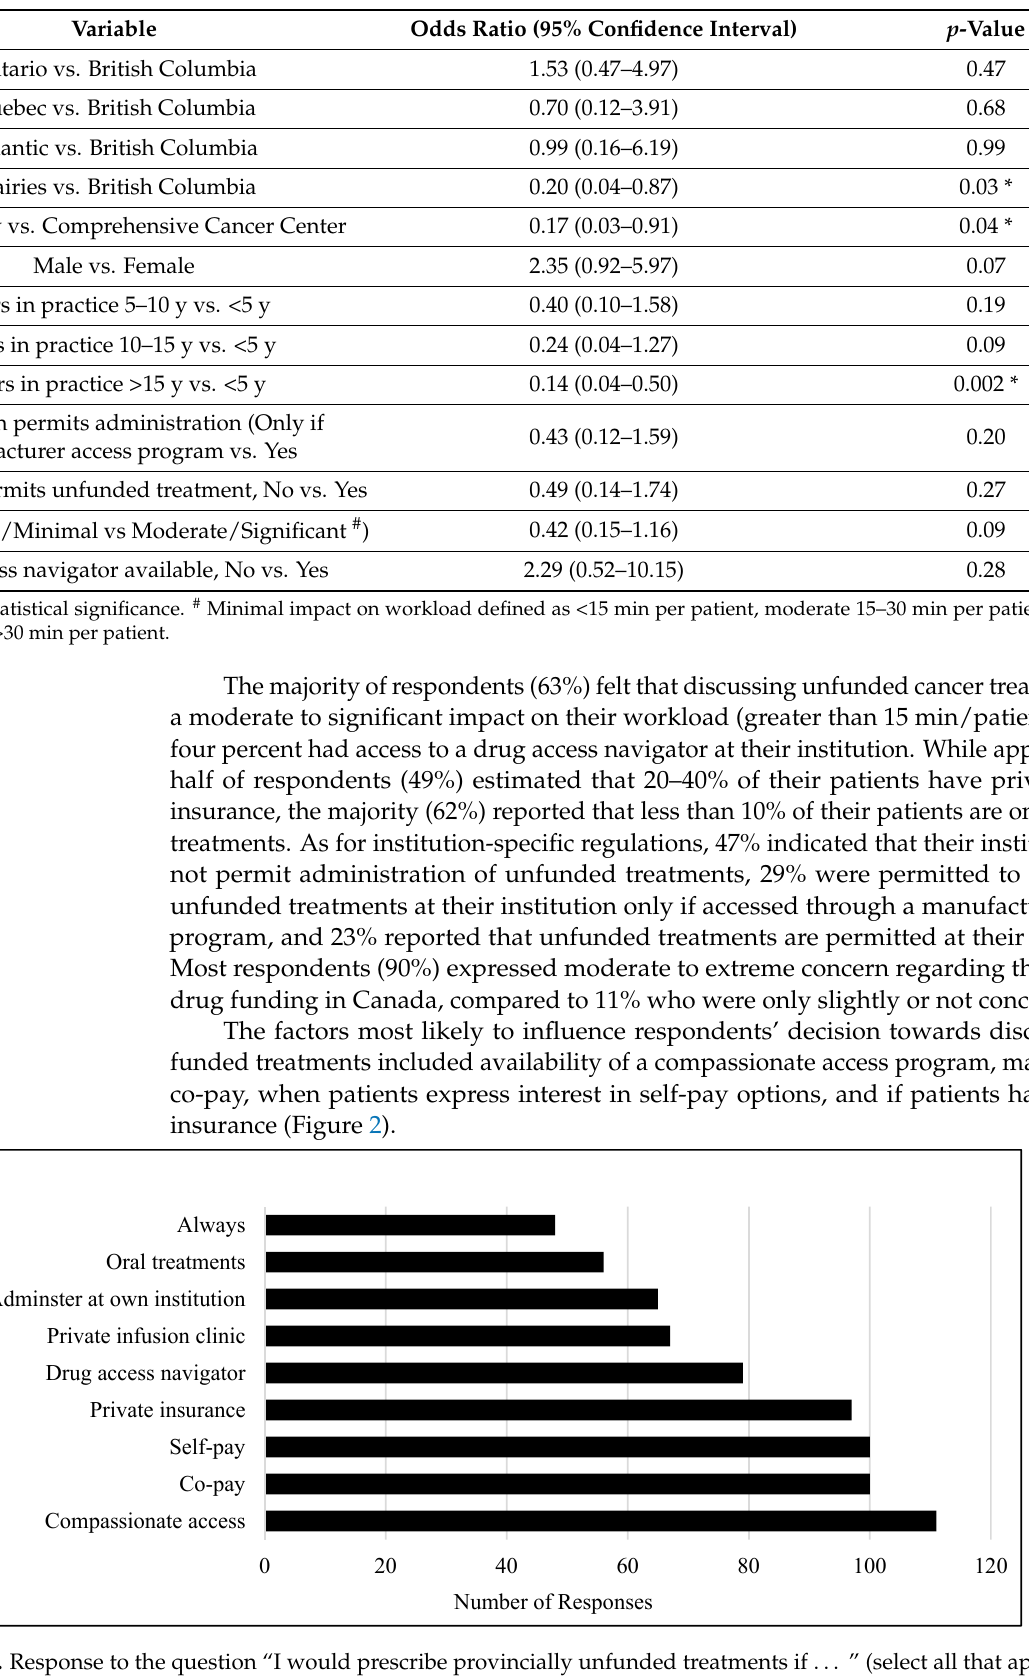
Table 2. Likelihood of discussing off-label, unfunded treatment options.